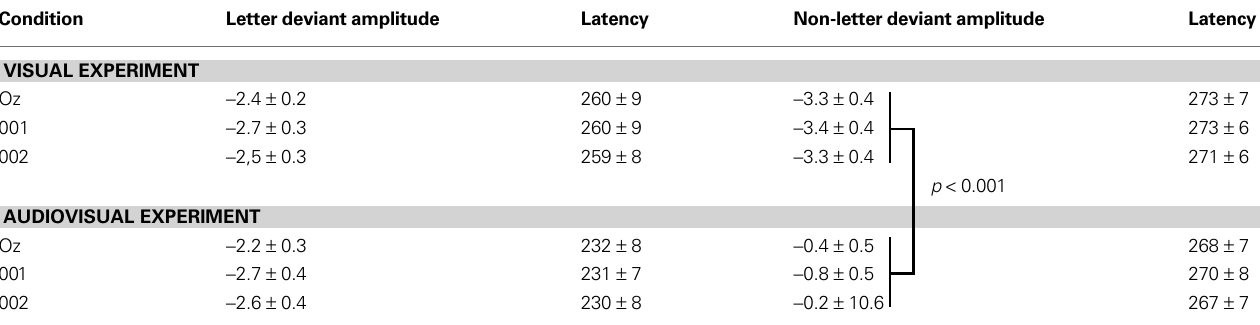
Table 1 | Mean area amplitude and peak latency measures of the difference waves with standard errors of the mean averaged over the three occipital electrodes Oz, O1 and